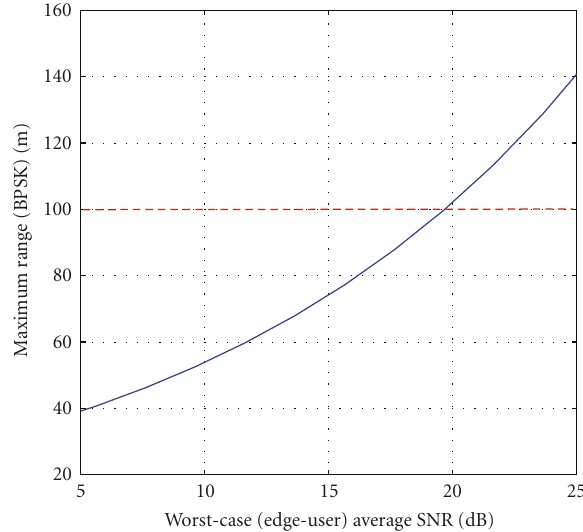
Figure 6: Maximum attainable range (BPSK coverage) versus worst-case (edge-user) average SNR (WASNR).